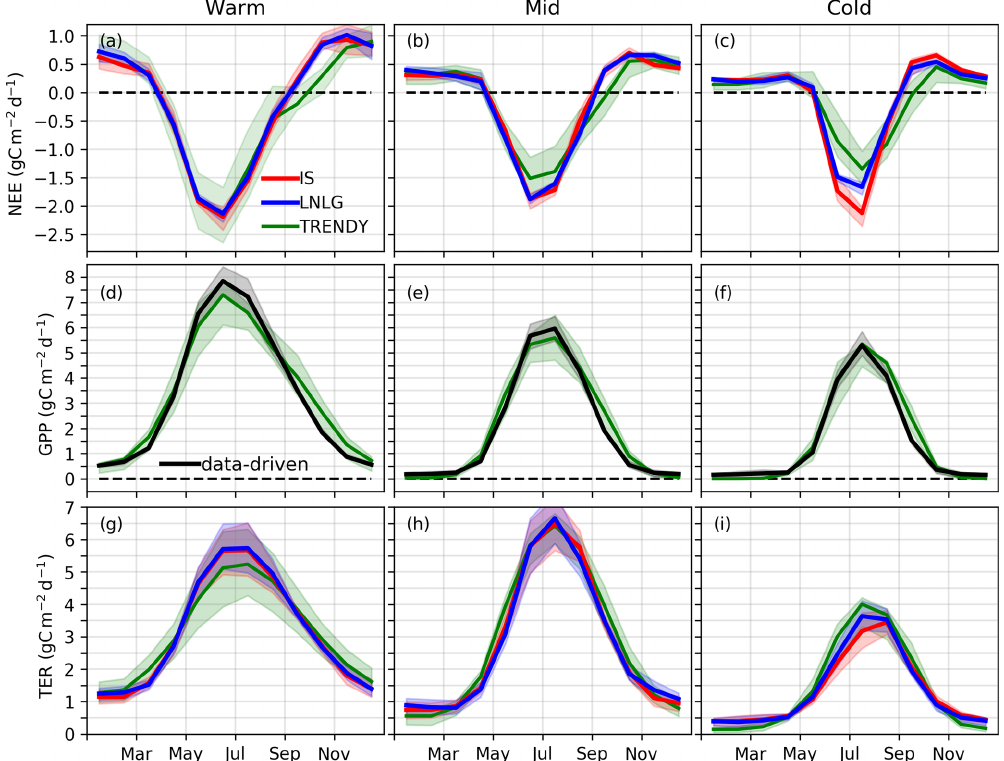
Figure 2. Monthly carbon cycle fluxes (average of 2015, 2016, and 2018; 2017 is excluded due to an OCO-2 data gap). (a–c) Mean (solid line) and interquartile range (shaded area) of NEE for the ensemble of IS (red) and LNLG (blue) v9 OCO-2 MIP and for the TRENDY ensemble (green). (d–f) GPP for the TRENDY ensemble (green) and data-driven datasets (black). (g–i) TER simulated by the TRENDY ensemble (green) and calculated from combining the data-driven GPP with the IS (red) and LNLG (blue) v9 OCO-2 MIP NEE